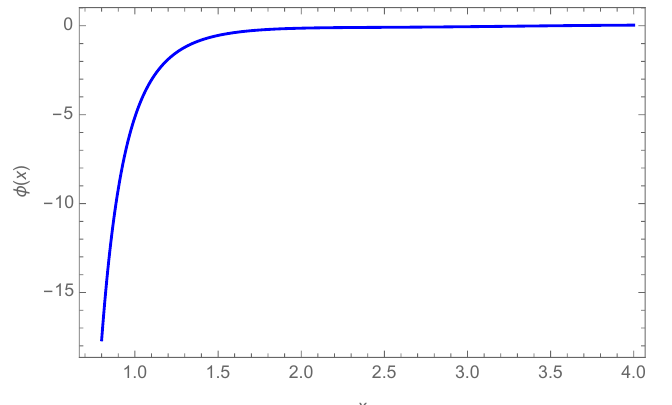
(cid:0) | (cid:1) ν | − Ω (also dimensionless).